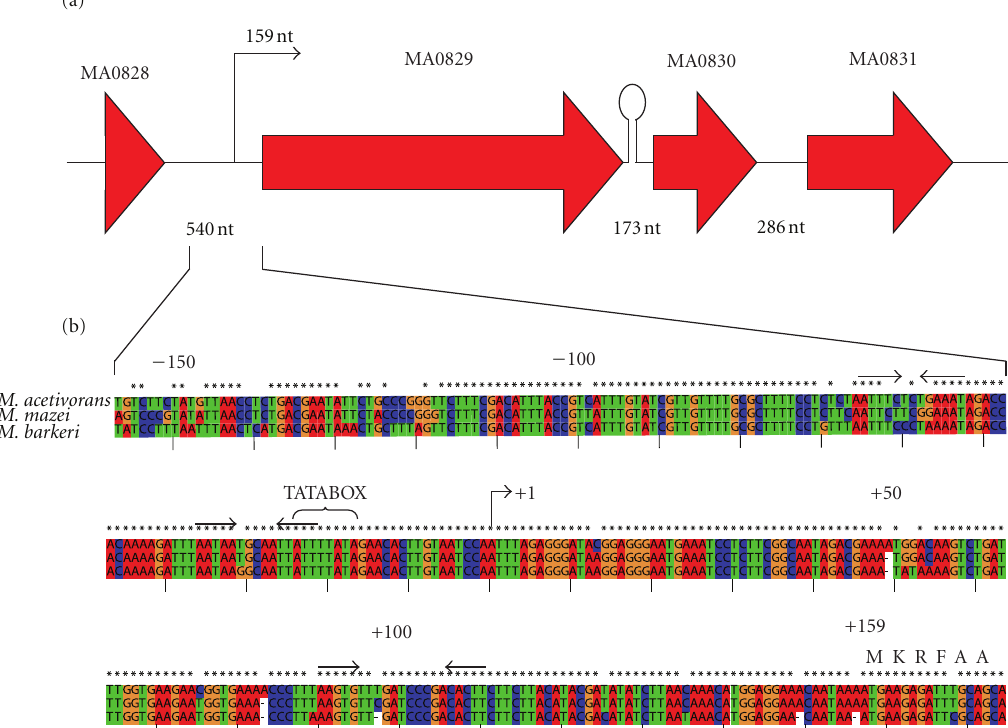
Figure 3: The M. acetivorans MA0829 gene locus and mRNA 5 (cid:3) end. (a) The MA0829-MA0831 gene region encodes the S-layer protein (MA0829), plus two hypothetical proteins of unknown function (MA0830 and MA0831). The Genebank name (MA number) is shown above each gene. A predicted hairpin loop is indicated between MA0829 and MA0830. Intergenic distances are in nucleotides. (b) Alignment of the upstream and untranslated leader regions of genes encoding the Methanosarcina S-layer protein. The alignment of the upstream DNA sequences is relative to the start of transcription (+1 position for M. acetivorans slmA1, see text) while the ATG position of the initiation codon is indicated by the M. Numbering is relative to the transcription start. Identity of the sequences is indicated by asterisks. The putative TATA-box sequences are indicated by the bracket. The mRNA 5 (cid:3) end positions for M. acetivorans and M. barkeri were determined with a ubiquitous ladder (data not shown). The six first N-terminal amino acids for the unprocessed M. acetivorans MA0829 preprotein are indicated by the single amino acid code.